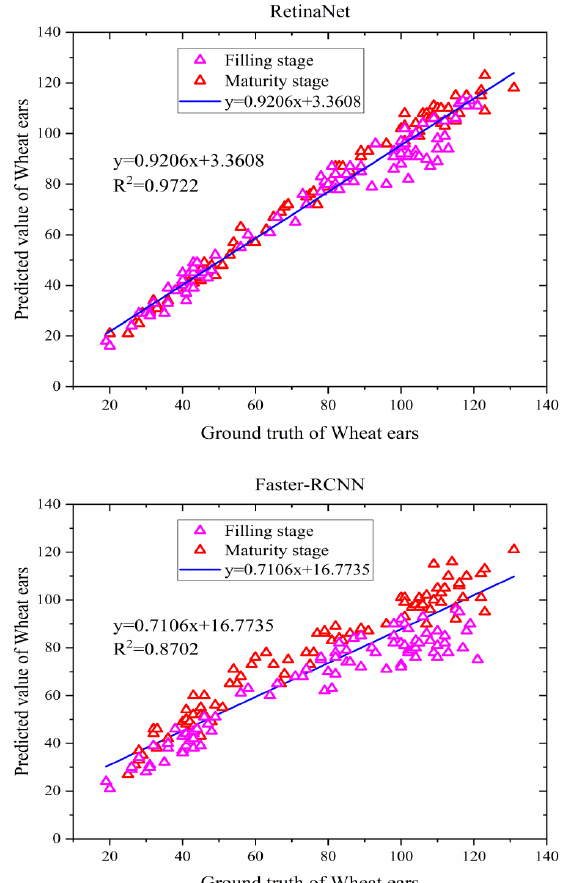
Figure 12. Scatter plot of recognition value and real value of wheat ear in RetinaNet and Faster R-CNN models.